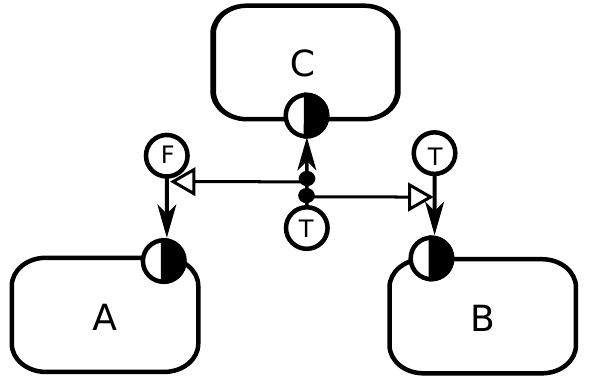
Figure 2.44: Independent events in Entity Relationship can not describe Figure 2.43 on the previous page.